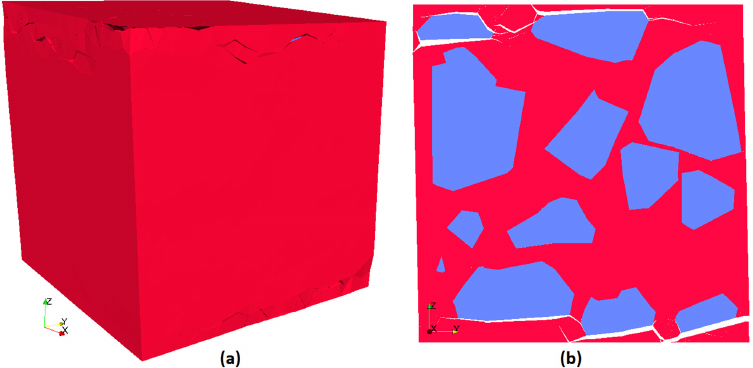
Figure 11. Final deformed shape for load applied in z-direction: ( a ) 3D view and ( b ) slice view.